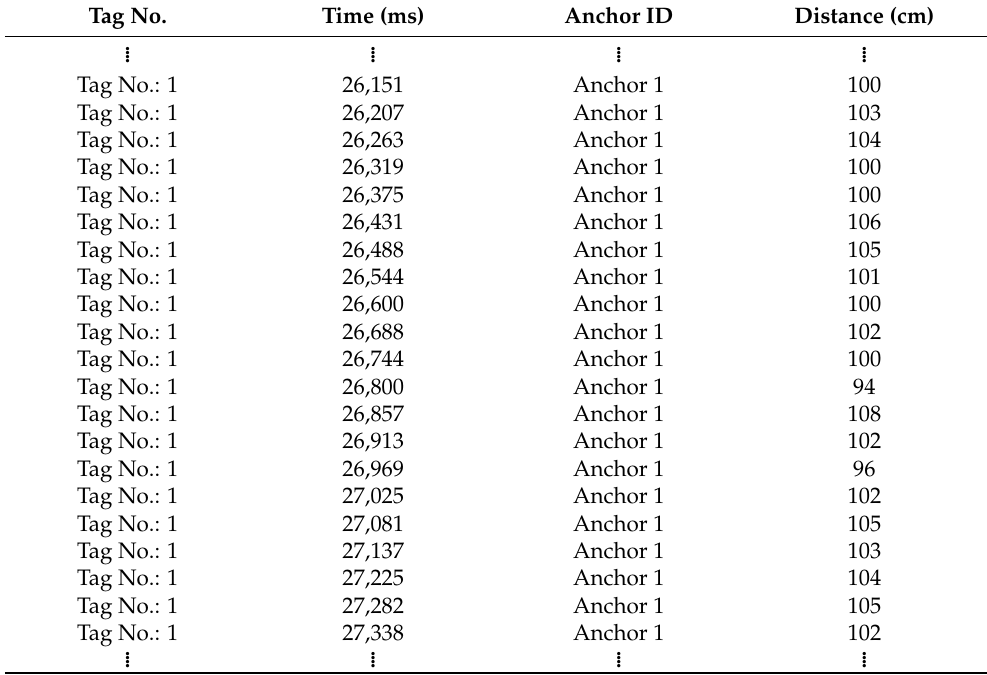
Table 2. Sample data table for anchor 1.